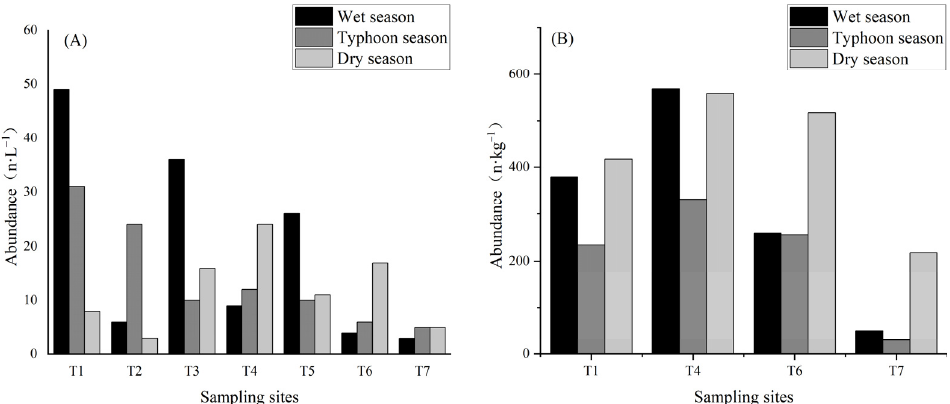
Figure 2. Abundance of MPs in different seasons. ( A ) denotes water sample, while ( B ) represents sediment sample.